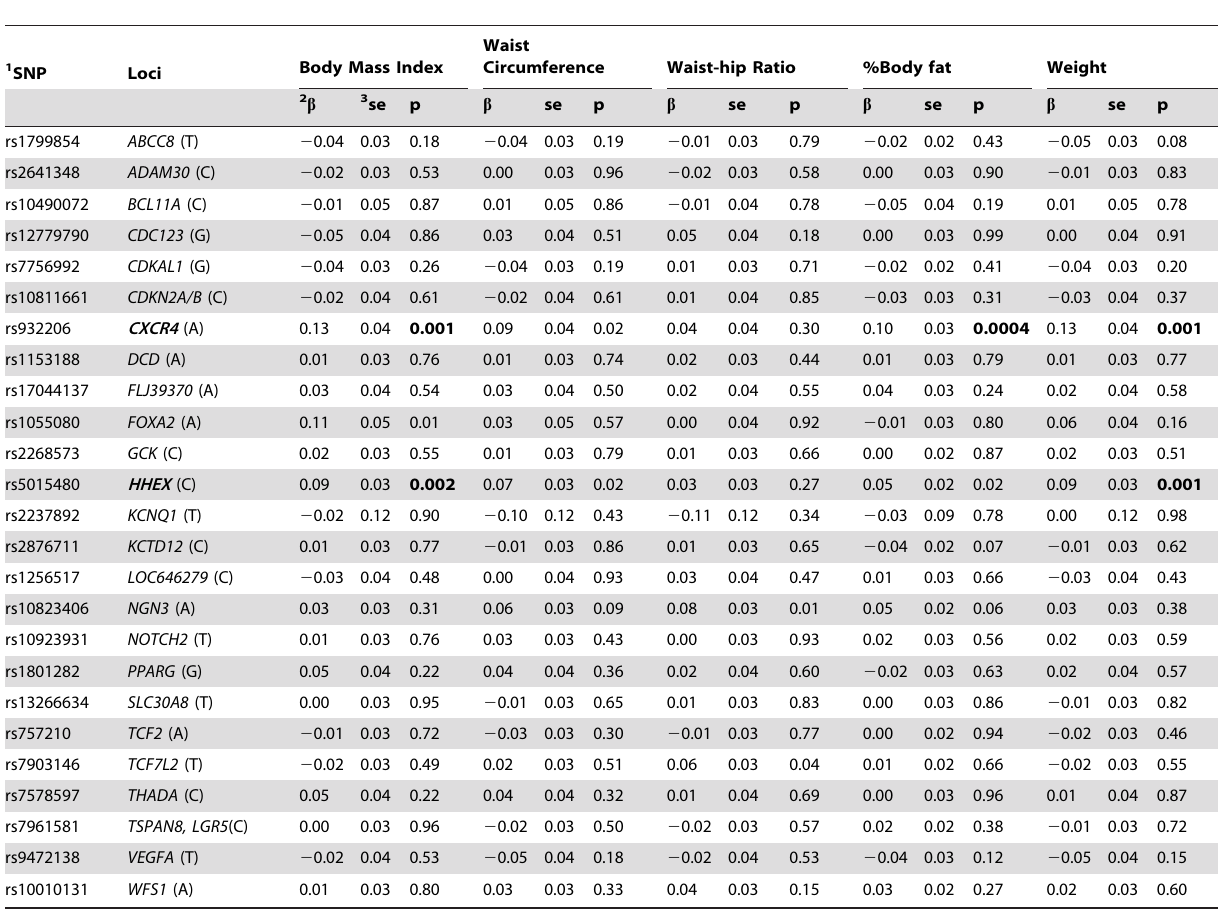
Table 2. Within sib-pair association estimates for phenotypes related to